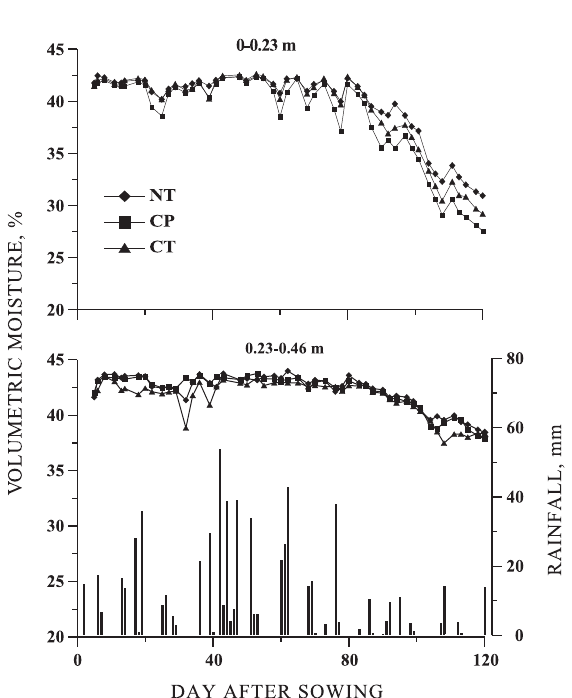
Figure 6. Volumetric moisture (curves) in two layers and rainfall (bars) during the corn cycle in three tillage systems (averaged across nutrient sources). (VM: volumetric moisture; NT: no- tillage; CP: chisel plow; CT: conventional tillage).